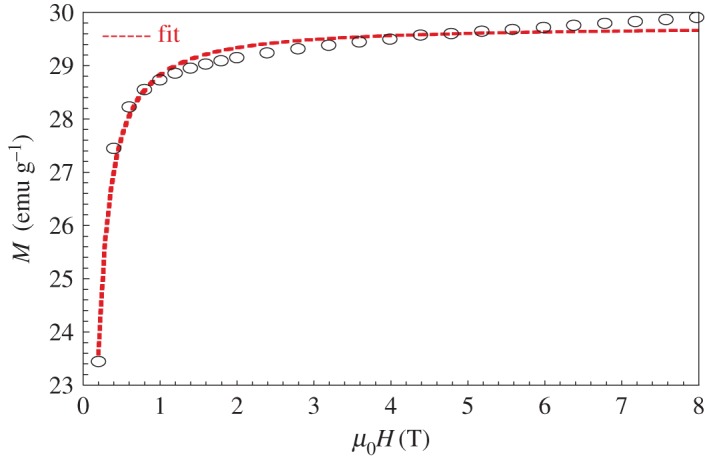
The simulated curve M (μ0H) at 10 K for the LaNaMnMoO6 sample.